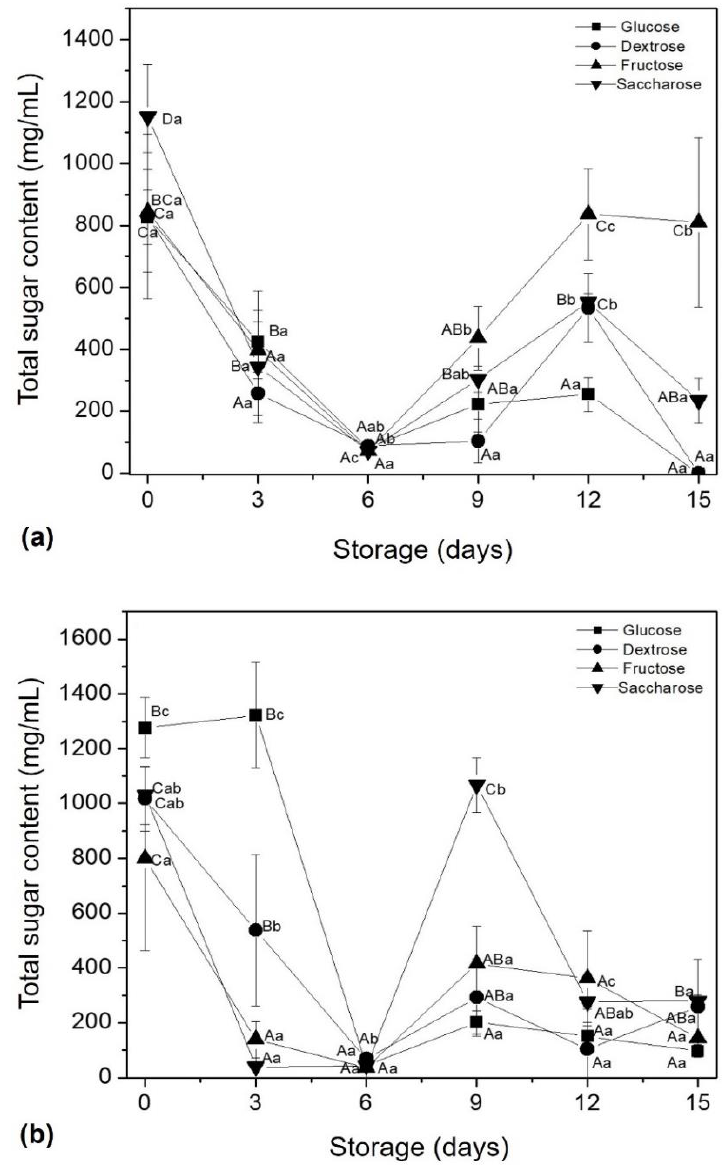
Figure 1. Total sugar content of kombucha fermentations ( a ) COr and ( b ) CFr stored at 25 °C for 15 days. Mean ± standard deviation. Letters (A, B, C) indicate significant differences between carbon sources by day, and letters (a, b, c) indicate a significant difference for the same carbon source during storage.